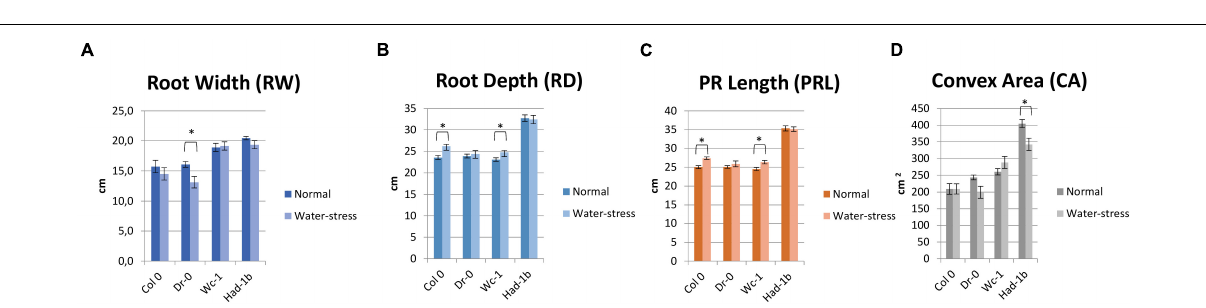
FIGURE 4 | (A–D) Results of measurements for root system architecture (RSA) traits, on four accessions tested in the rhizotron set-up, for normal and mild-stress conditions. *, p < 0.05 as analyzed by a Student’s t